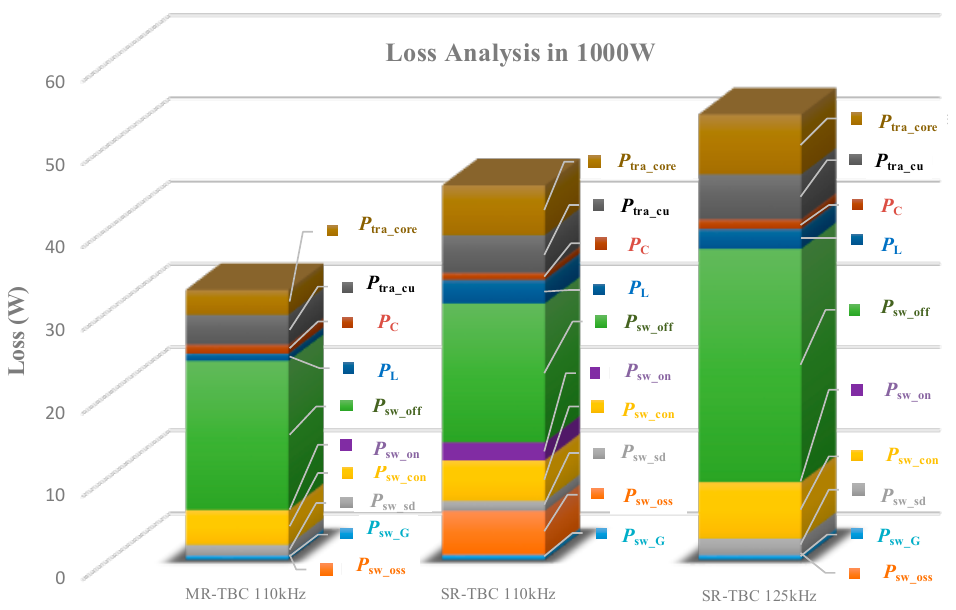
Figure 12. Loss calculation comparison of MR-TBC and SR-TBC under 1000 W.